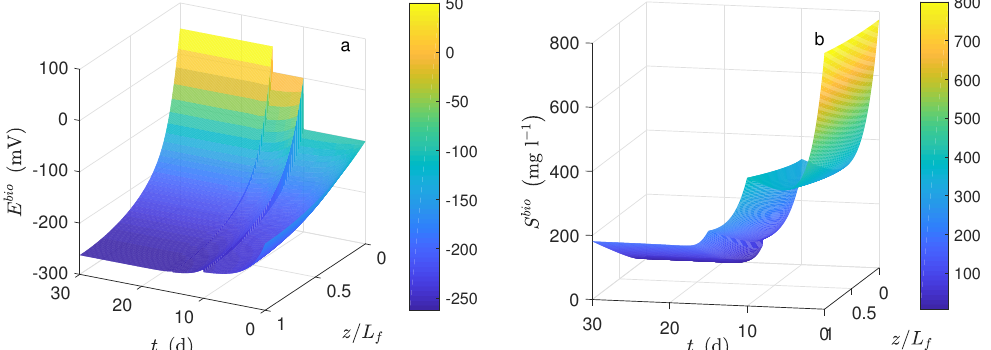
Figure 6. Numerical solution for the MEC model during chronoamperometry operation. ( a ) Potential distribution in the biofilm and ( b ) substrate distribution in the